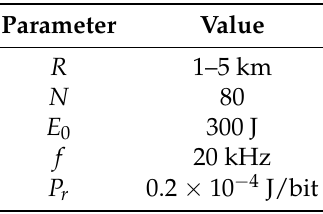
Table 3. Simulation